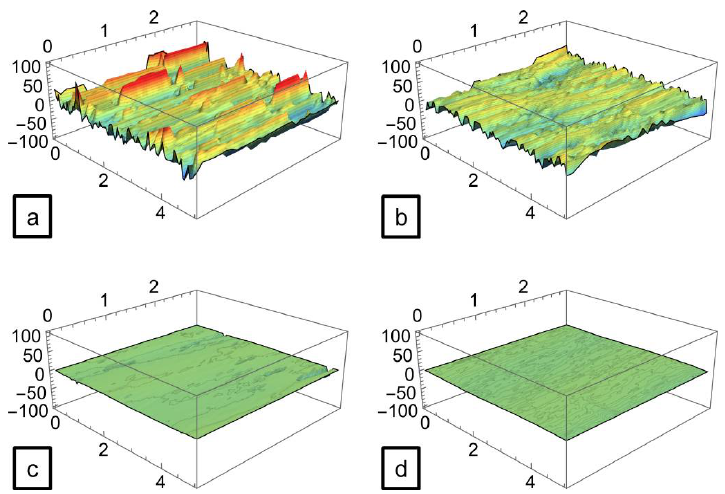
Figure 15. Propeller external SLMed surface after ( a ) 24 h ( b ), 48 h ( c ), and 96 h ( d ) BF working time.